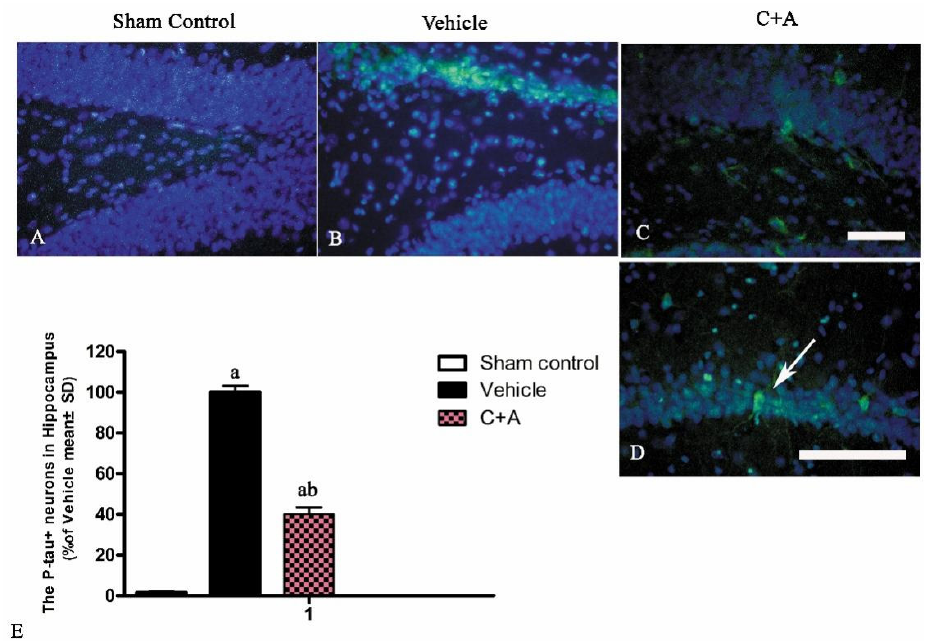
Figure 13. ( A – D ) Immunofluorescence staining (green) of p-tau in the hippocampus. The white arrow in ( D ) indicates a neuron expressing p-tau. The cell nuclei in the cortex and hippocampus were visualized by Hoechst 33342 staining (blue). ( E ) Quantification of p-tau-positive cells showed that treatment with C16 plus Ang-1 reduced the expression of p-tau in AD rats. Scale bar = 100 µm. a, p < 0.05 vs. sham control group; b, p < 0.05 vs. vehicle group.